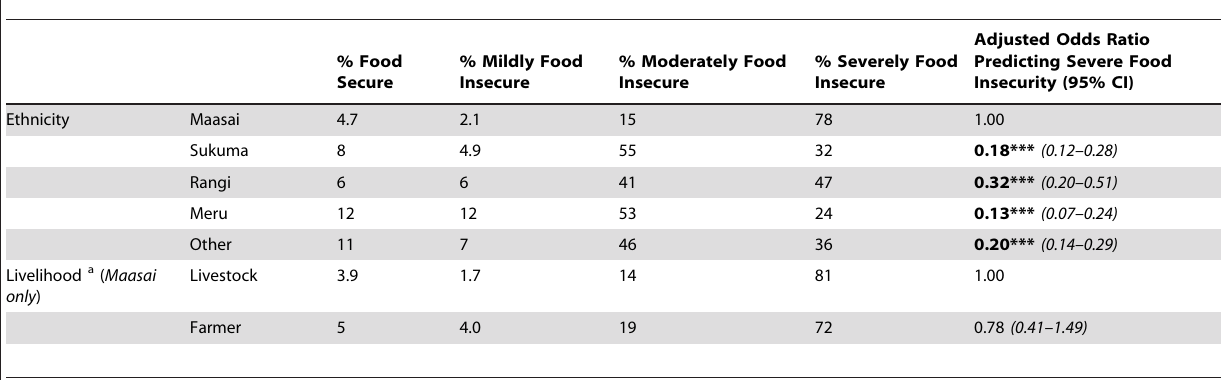
Table 4. Multilevel Logistic Regression Predicting Household Food Insecurity (n=